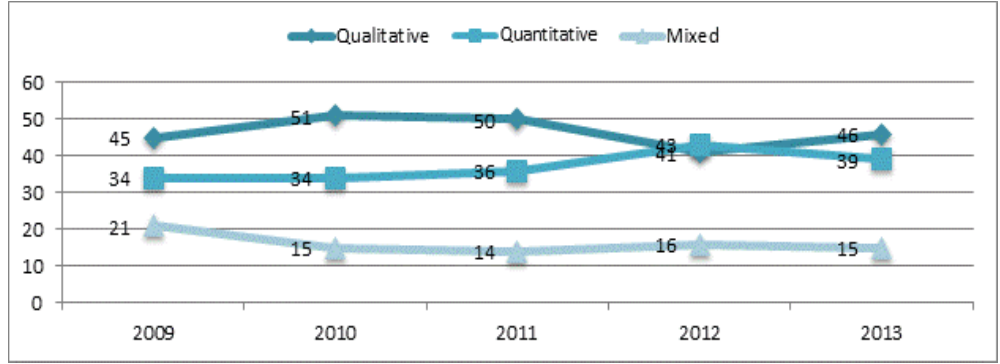
Line Chart Of Research Methods (Percentage Was Calculated Separately For Each